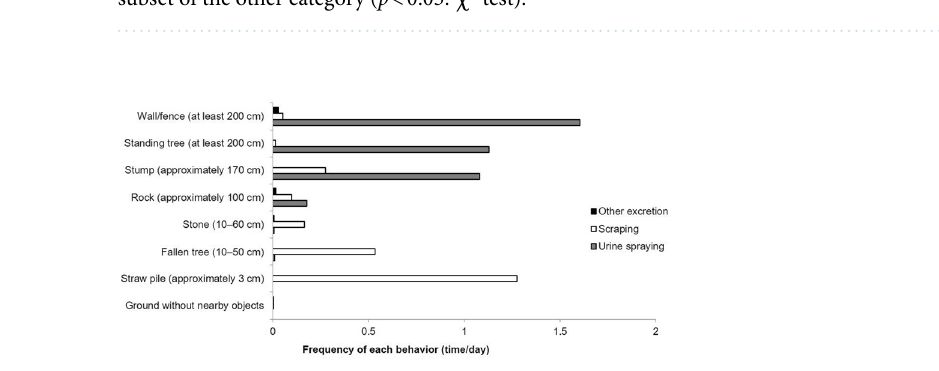
Table 5. Sniffing associated with urine spraying and scraping. a,b Denotes a subset of the excretion category (urine spray, scraping, and other excretion) whose ratio was not significantly different from the ratio of the subset of the other category ( p < 0.05: χ 2 test).